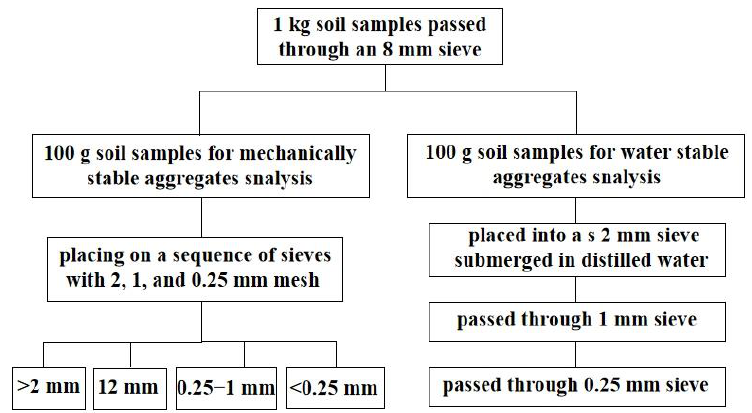
Figure 2. Schematic to a flow chart of the processing of the samples.